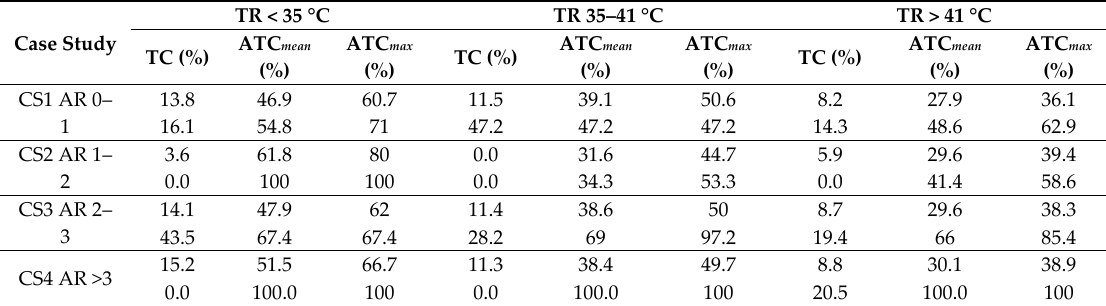
Table 2. Outdoor versus courtyard DTR percentages within TC, ATC mean , and ATC max